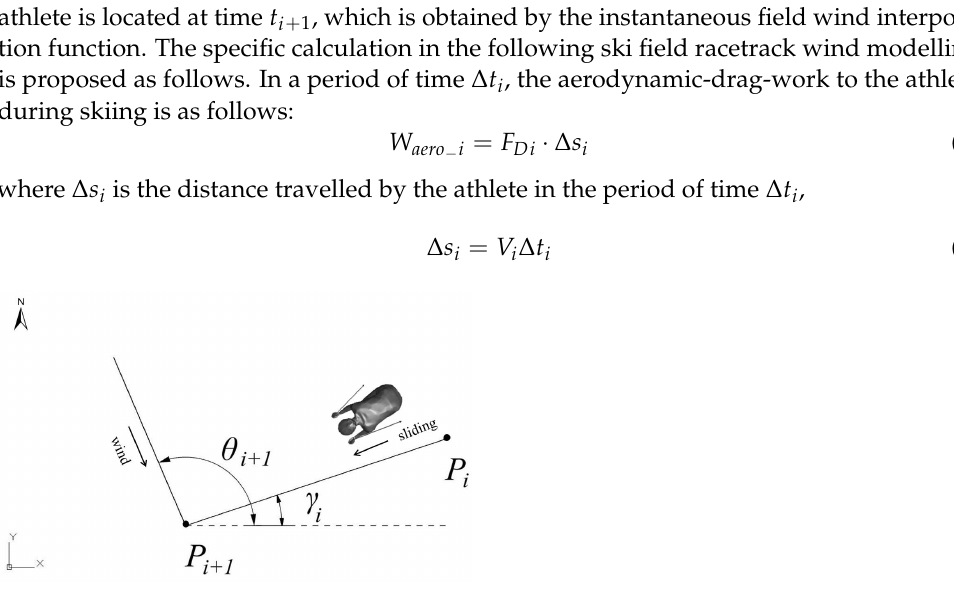
Figure 1. The relationship between the field wind direction and the angle of the athlete’s sliding direction.